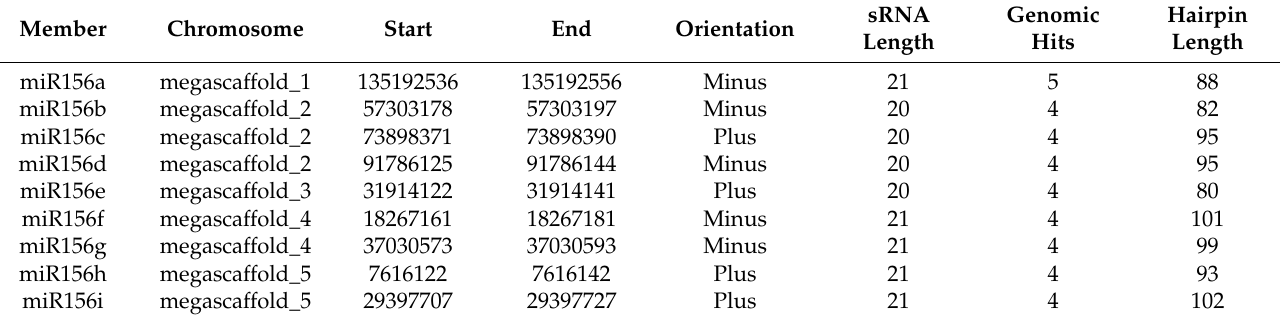
Table 2. Information of lotus miR156 family